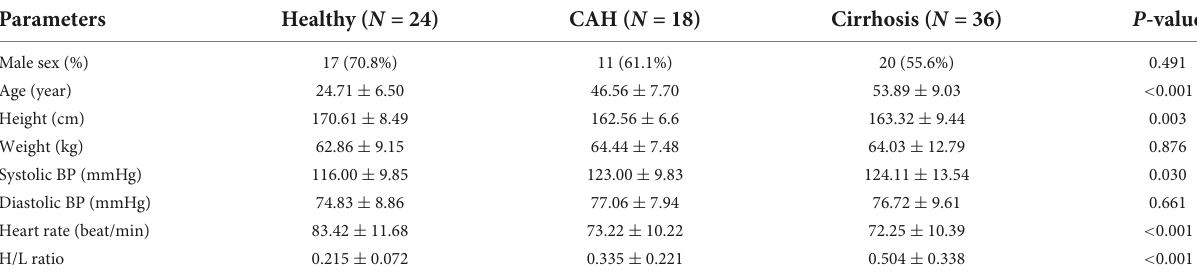
TABLE 1 Baseline characteristics of the subjects who completed